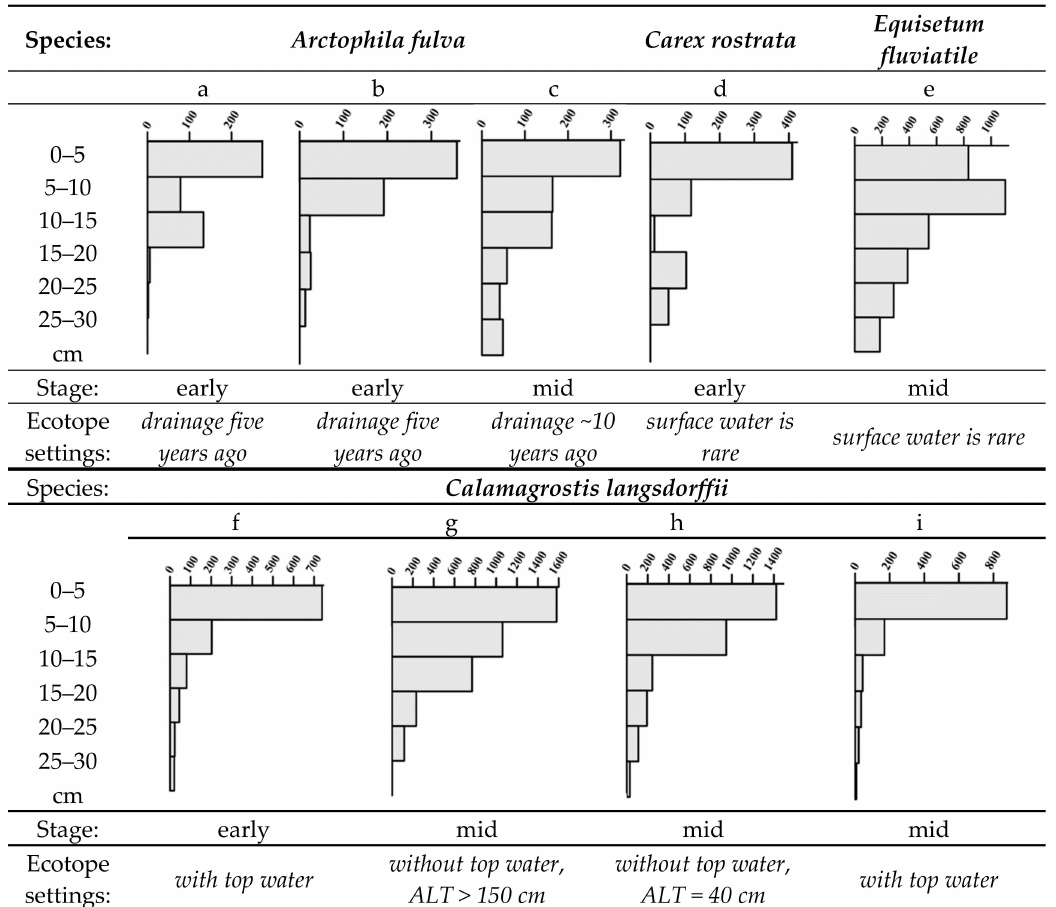
Figure A3. The mass of living roots in the soil layer of 0–30 cm (g / m 2 ). The meadows dominated by: ( a – c )— Arctophila fulva (sites tz18–28, tz18–47, and tz18–24, respectively); ( d )— Carex rostrata (tz18–46); ( e )— Equisetum fluviatile (tz18–51); ( f – i )— Calamagrostis langsdor ffi i (tz18–27, tz18–50, tz18–52, and tz18–53, respectively).